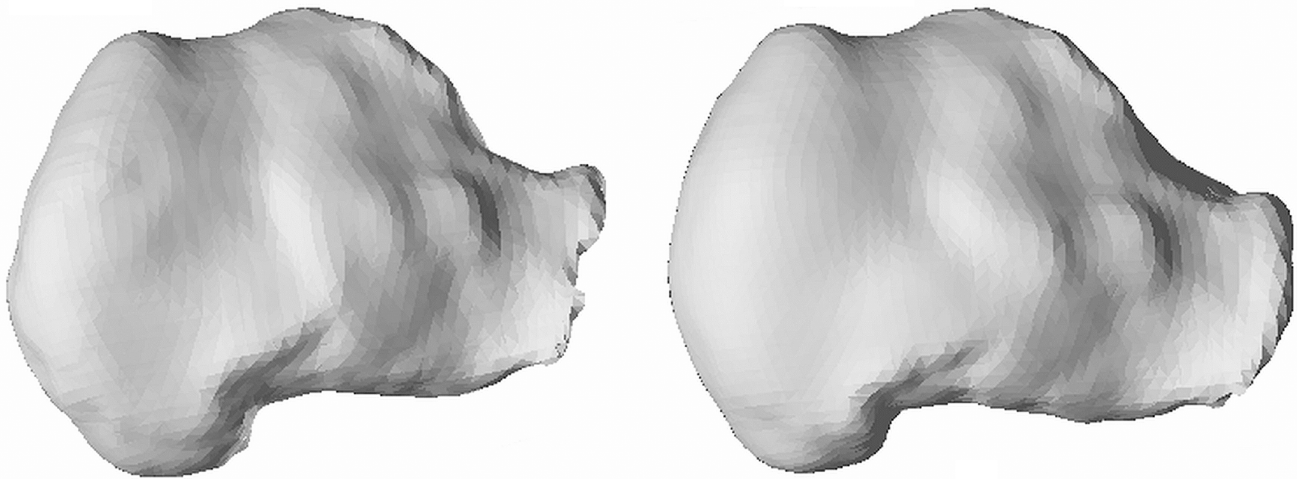
Fig 6. An example of reconstructed SSM of right calcaneus using the whole set of 144 spherical harmonic coefficients (left) and the reduced set of 41 representative coefficients (right). doi:10.1371/journal.pone.0134603.g006 Table 1. The group statistics (MEAN ± SD) of the morphological characteristics of the calcaneus based on landmark distances. both calcanei left calcaneus right calcaneus LCA [mm] 80 ± 6